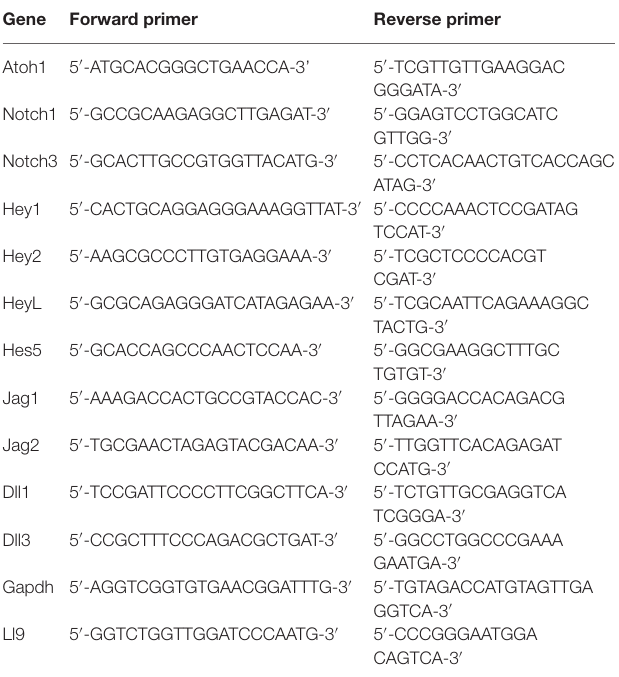
TABLE 1 | Q-PCR primers for Figures 1, 3, 5, 7